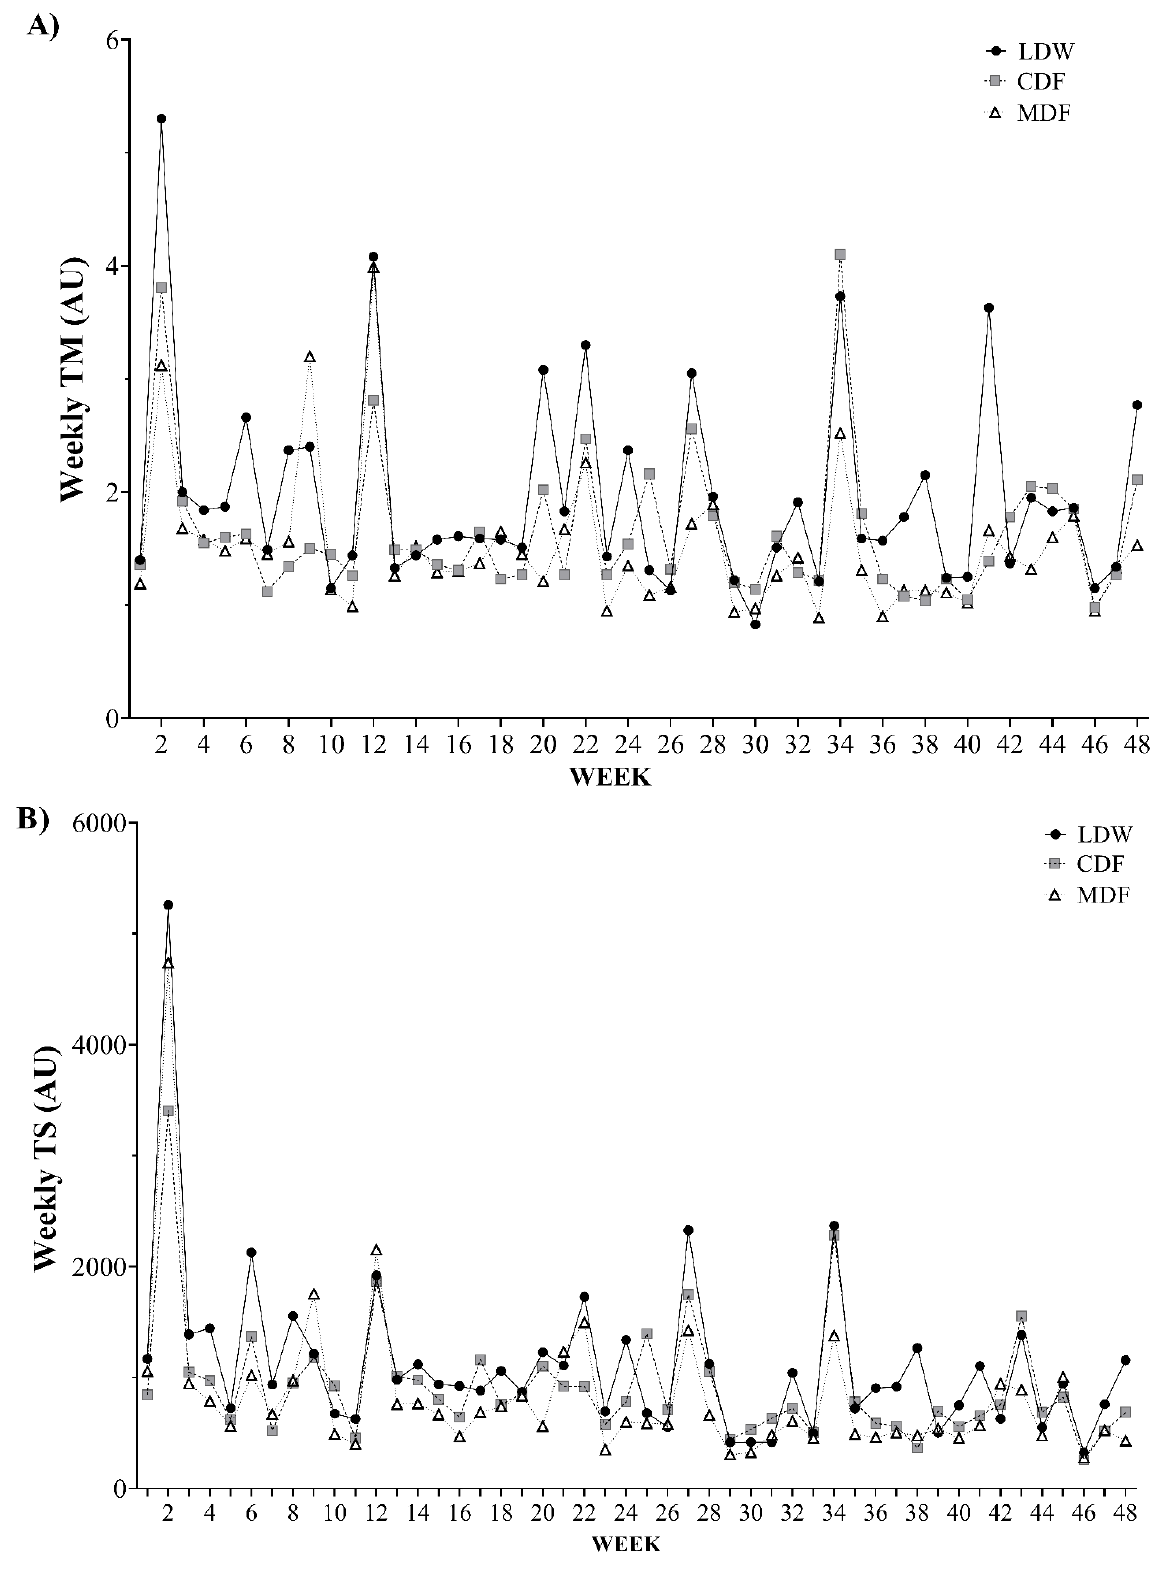
Figure 6. Descriptive statistics of ( A ) training monotony (TM), ( B ) training strain (TS), and their variations across the full season, considering the weekly averages of body load. AU, arbitrary units; LDW, lateral defenders and wingers; CDF, central defenders and forwards; and MDF, midfielders.